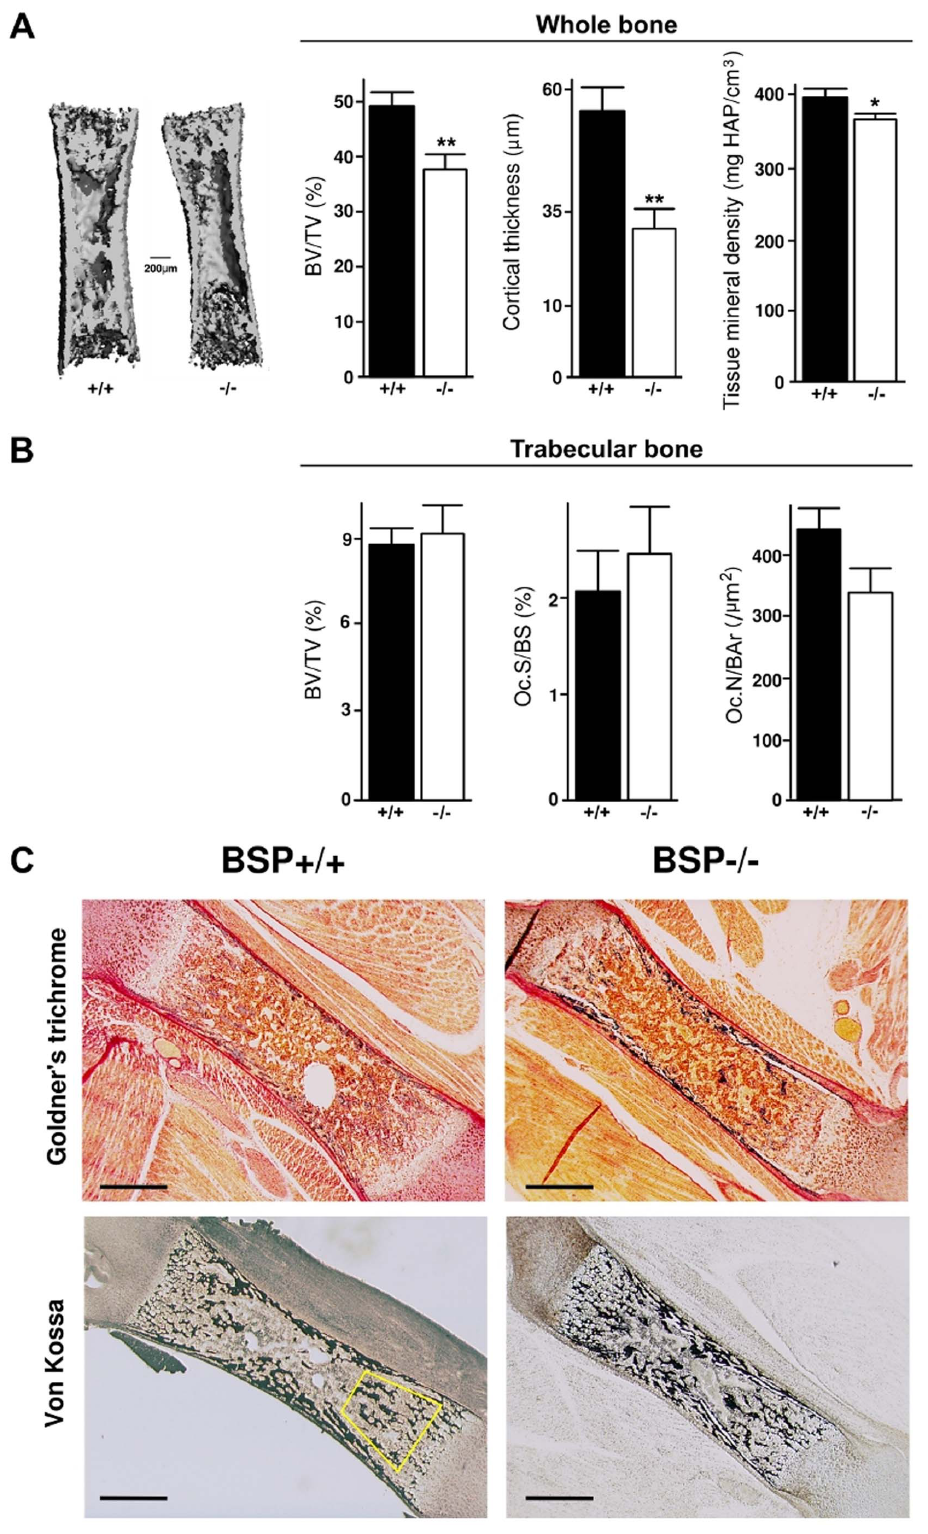
Figure 5. Morphology and morphometry of the long bones in newborn BSP + / + and BSP 2 / 2 mice. (A) 3D m CT reconstruction and morphometry of newborn whole femurs from BSP + / + ( + / + ) and 2 / 2 newborn mice. (B) Histomorphometry of trabecular bone in newborn femurs from + / + and 2 / 2 mice. Data are Mean 6 SEM of N=4 to 10 mice; *:p , 0.05, **:p , 0.01 Vs + / + , Mann-Whitney U Test. (C) Micrographs of Goldner’s trichrome and Von Kossa staining of BSP + / + and BSP 2 / 2 newborn femur sagittal sections. Yellow polygon: ROI for histomorphometry of the trabecular bone. Bar =400 m m.